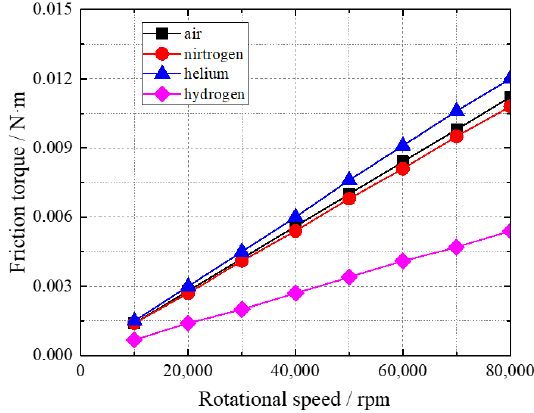
Figure 7. Bearing friction torque with rotational speed for the four different gases. The critical masses of the bearings with rotational speed for the four different gases are shown in Figure 8. When the rotational speed is low, the critical mass is relatively high. The critical mass begins to decrease with increasing rotational speed. The critical mass of the helium-lubricated bearing is close to those of the air- and nitrogen-lubricated bearings, and all of them are higher than that of hydrogen-lubricated bearing. The critical masses of the bearings when using different gases can be ordered from high to low as: helium, air, nitrogen and hydrogen.